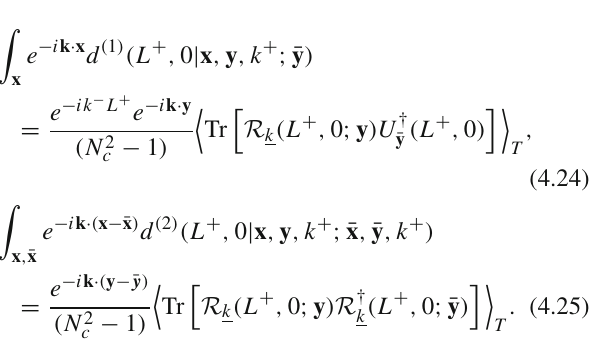
√ s NN and for p ⊥ = 2